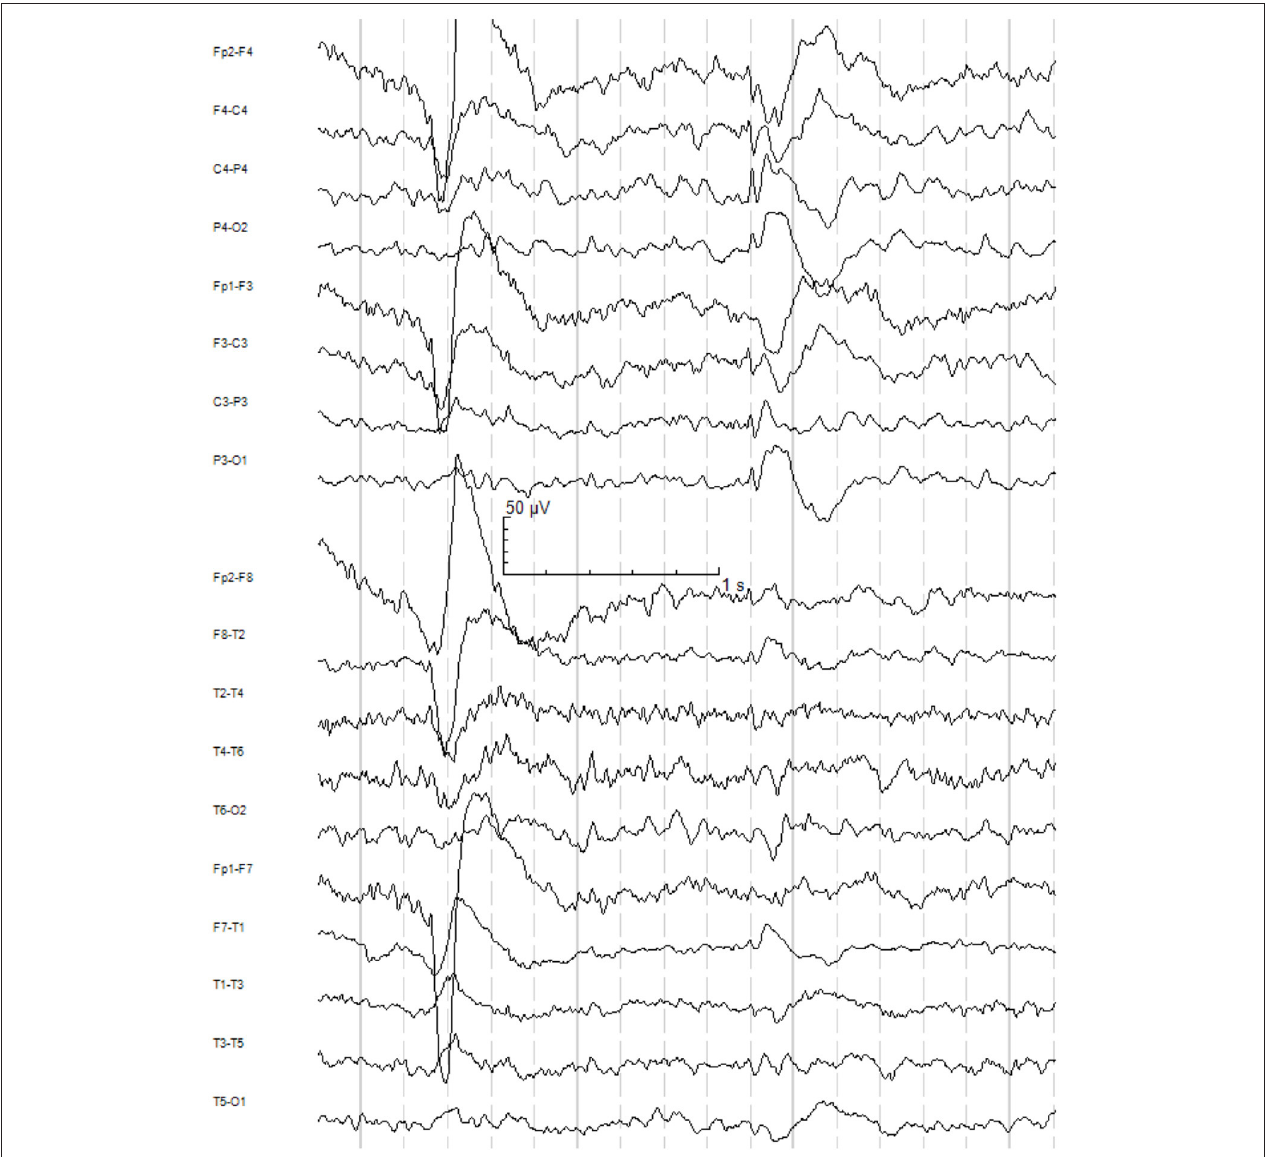
FIGURE 2 | Ictal EEG recording during long-term video-EEG monitoring: Generalized spike-wave complex with fronto-central maximum associated with a habitual myoclonic jerk of the right hand during writing. Longitudinal bipolar montage, 50Hz notch filter, low-pass filter 30Hz, high-pass filter 1